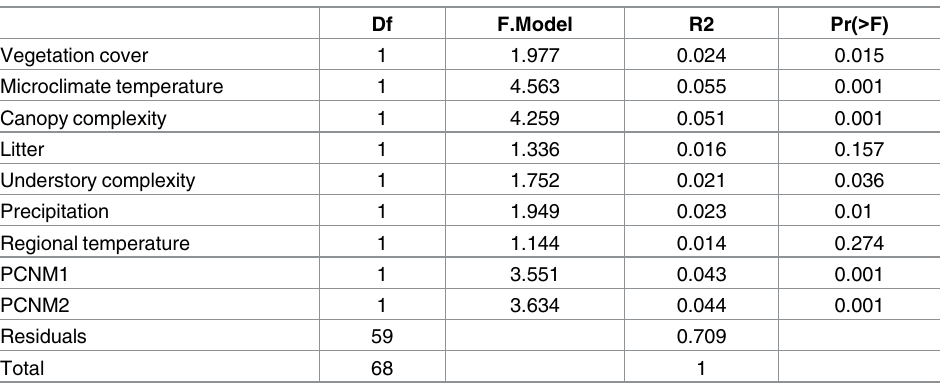
Table 4. Result of the Multivariate Distance Matrix regression (MDMR) of species composition and environmental variables variables in Caatinga areas, in the Serra da Capivara and Serra das